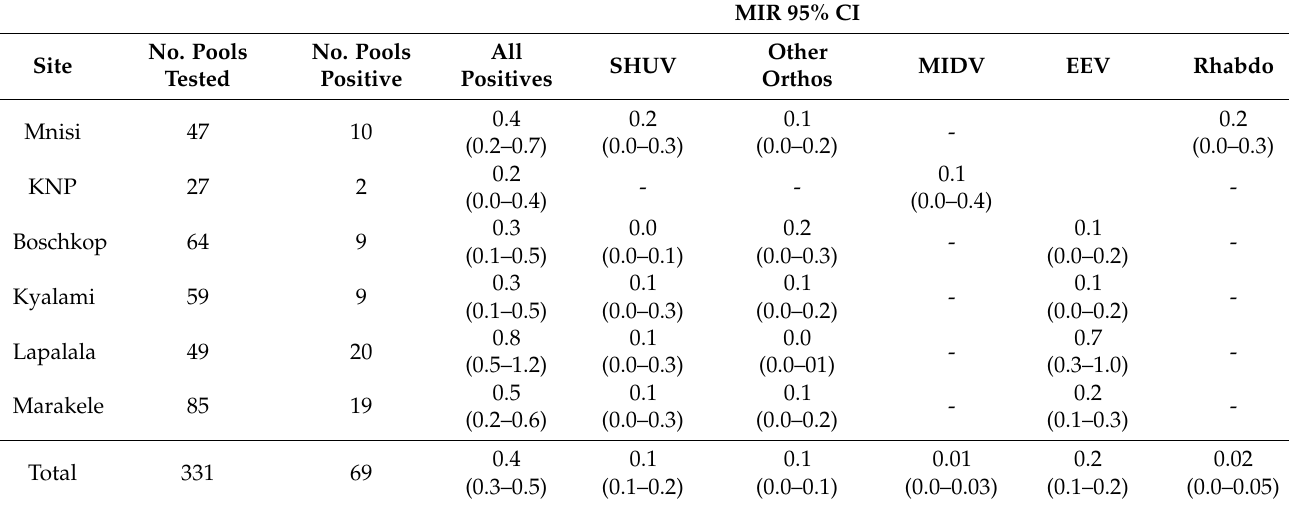
Table 2. Viruses detected at the six collection sites, in three provinces in South Africa, with total number (no.) of Culicoides pools screened by PCR, number of positives pools for each viruses detected as well as the minimum infection rate (MIR) with 95% confidence interval (CI) indicated. Culicoides were collected monthly from September 2012 to May 2017 for two consecutive nights using 220 V Onderstepoort light